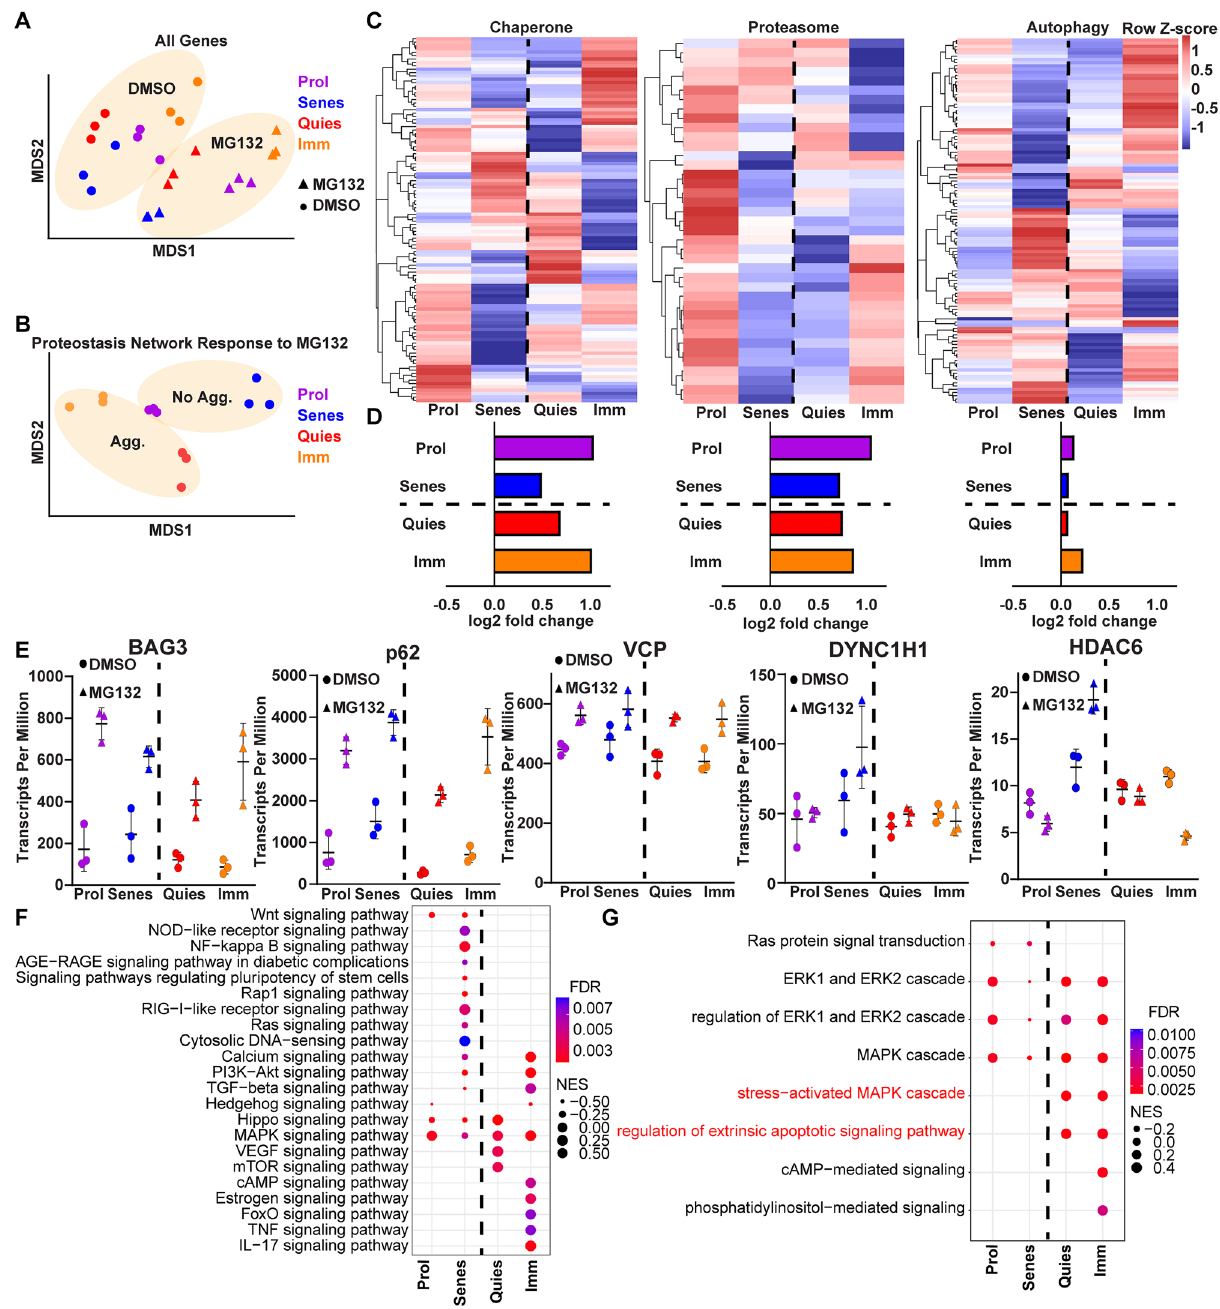
Figure 3. Transcriptional profiling of the fibroblast cell-state specific response to proteasome inhibition reveals stress-activated MAPK signaling associated with aggresome formation. ( A ) MDS analysis of the global transcriptomes of proliferating (purple), senescent (blue), quiescent (red), and immortalized (orange) fibroblasts treated with either 0.1% DMSO (circles) or 10 µM MG132 (squares) for 8 h. Ovals denote clustering of DMSO or MG132 conditions. ( B ) MDS analysis of the proteostasis network’s (chaperone, proteasome and lysosome genes) transcriptional response to proteasome inhibition in proliferating, senescent, quiescent, and immortalized fibroblasts. Ovals denote clustering of aggresome-forming or -lacking cell-states. ( C ) Heat maps depicting differential expression of chaperone, proteasome, or autophagy genes in response to MG132 between proliferating, senescent, quiescent, or immortalized fibroblasts. ( D ) Average DEseq2 log2-fold change values for all chaperone, proteasome, or autophagy genes as proliferating, senescent, quiescent, and immortalized fibroblasts respond to MG132 treatment. ( E ) Transcript per million counts of representative genes implicated in aggresome formation in proliferating, senescent, quiescent, and immortalized fibroblasts treated with DMSO (circles) or MG132 (squares). ( F , G ) GO and KEGG analysis of the signaling pathways significantly differentially regulated in response to MG132 in proliferating, senescent, quiescent, and immortalized cells. FDR refers to false discovery rate and NES refers to normalized enrichment score. The dotted line in each panel separates cell- states that either do or do not form the